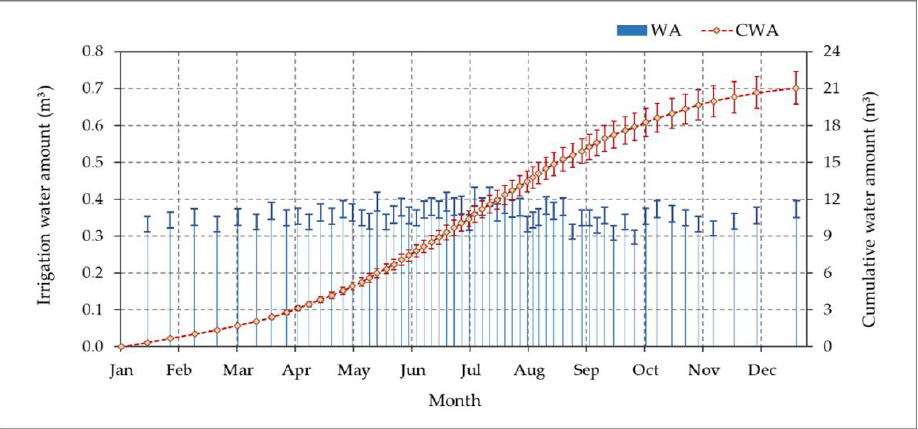
Figure 13. The mean applied irrigation water amount (WA) and the mean cumulative applied water amount in cubic meter (CWA) over the year 2020 in the experimental site using the designed controlled subsurface irrigation system (CSIS) with the sensor-based irrigation scheduling method (S-BIS).